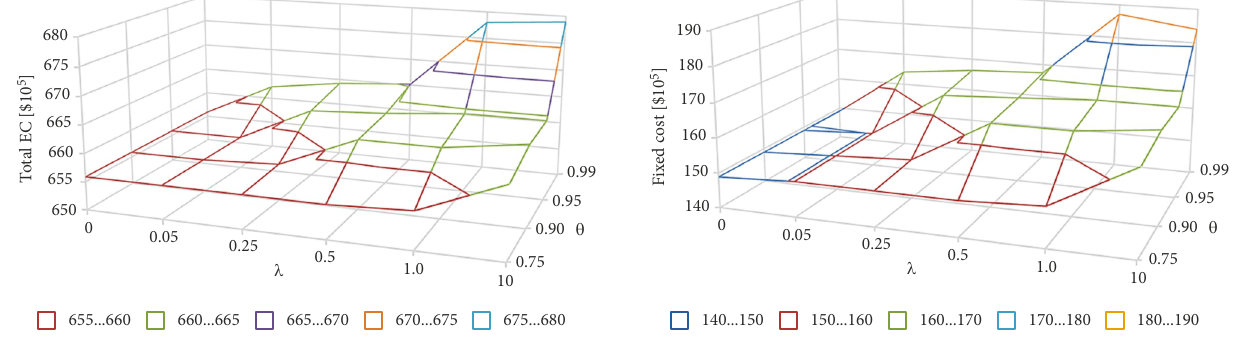
Figure 6. The optimal EC under different confidence levels for case 10–1